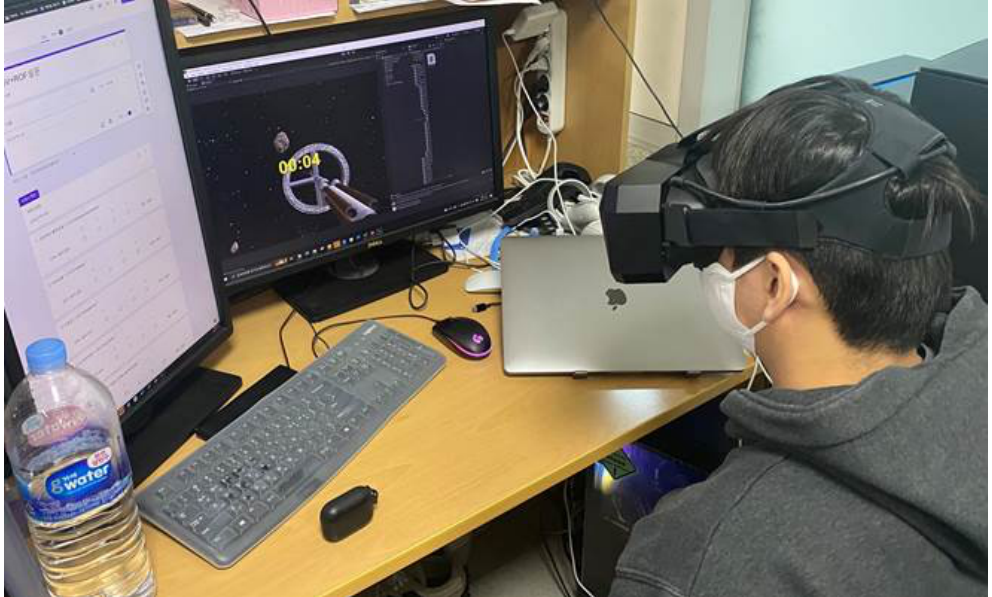
Figure 4. Snapshot of the subject experiencing the test